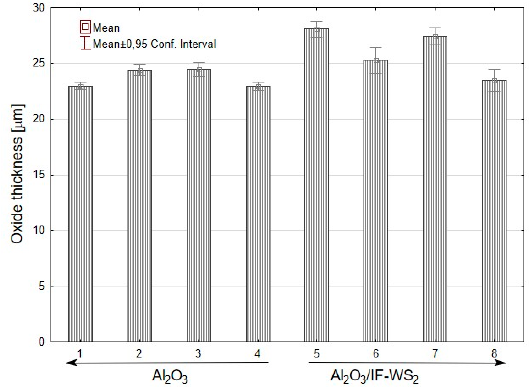
Figure 2. Anodizing voltage–time dependence for SAS and SAS electrolyte with admixture of IF-WS 2 .